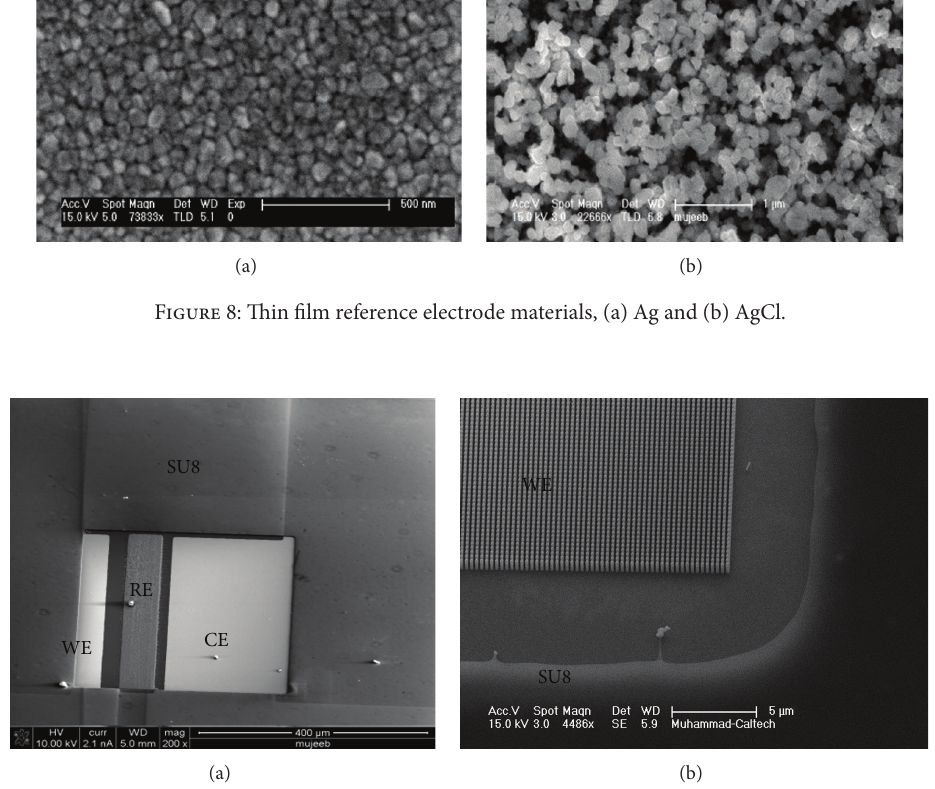
Figure 9: Polymer (SU8) encapsulation around sensors, (a) encapsulation around three-electrode sensor, and (b) higher resolution view showing pillars with SU8 encapsulation